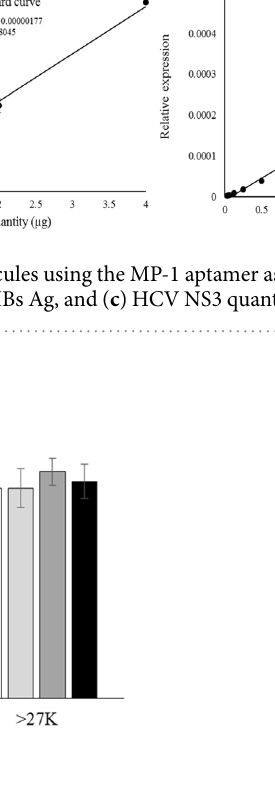
Figure 6. The recovered quantities of spiked target analytes in samples using the MP-1 aptamer as a capture